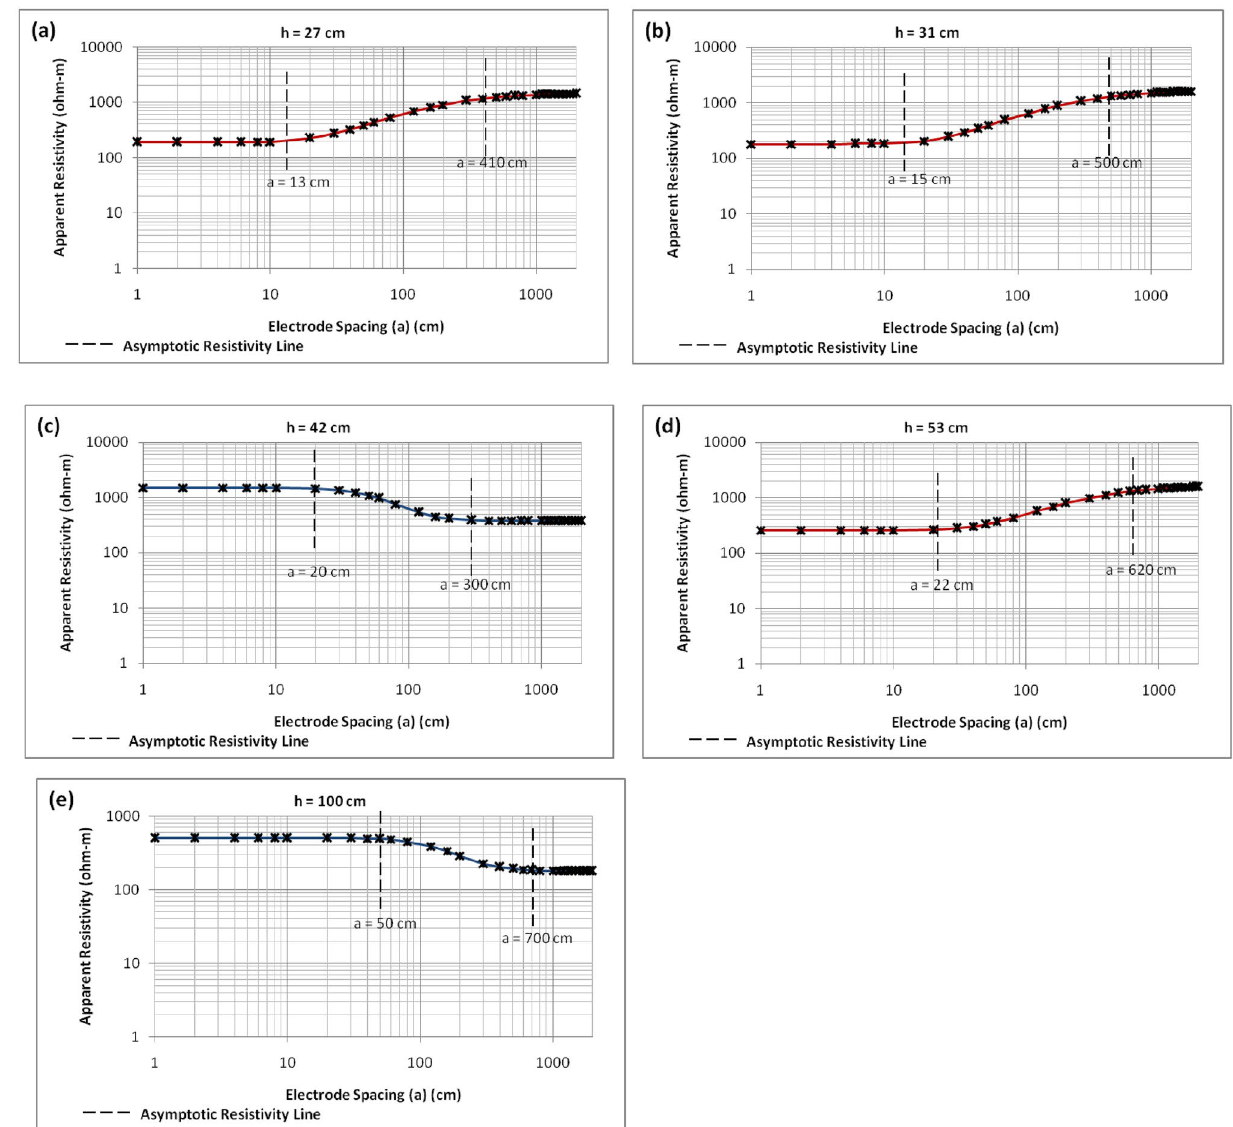
Fig. 6 Field curves. a h = 27 cm, b h = 31 cm. c h = 42 cm, d h = 53 cm, e h = 100